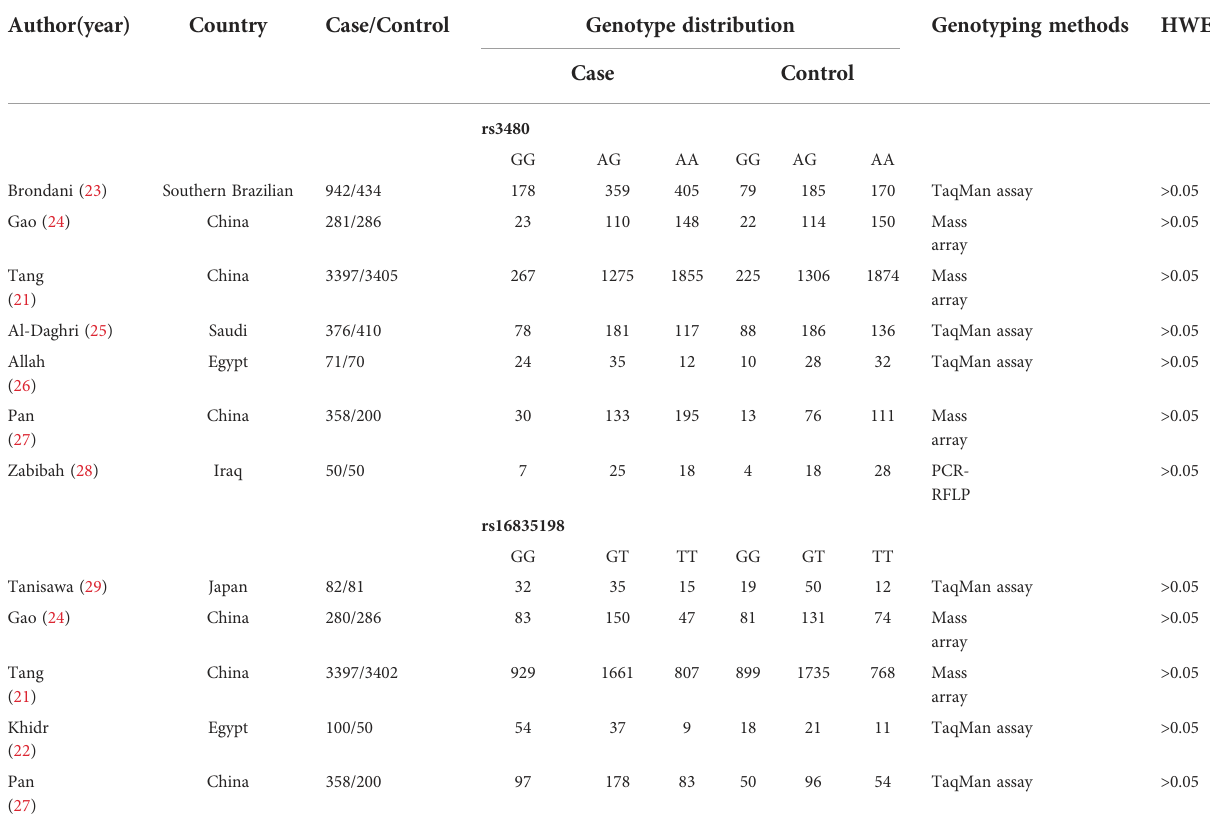
TABLE 2 Characteristics of included